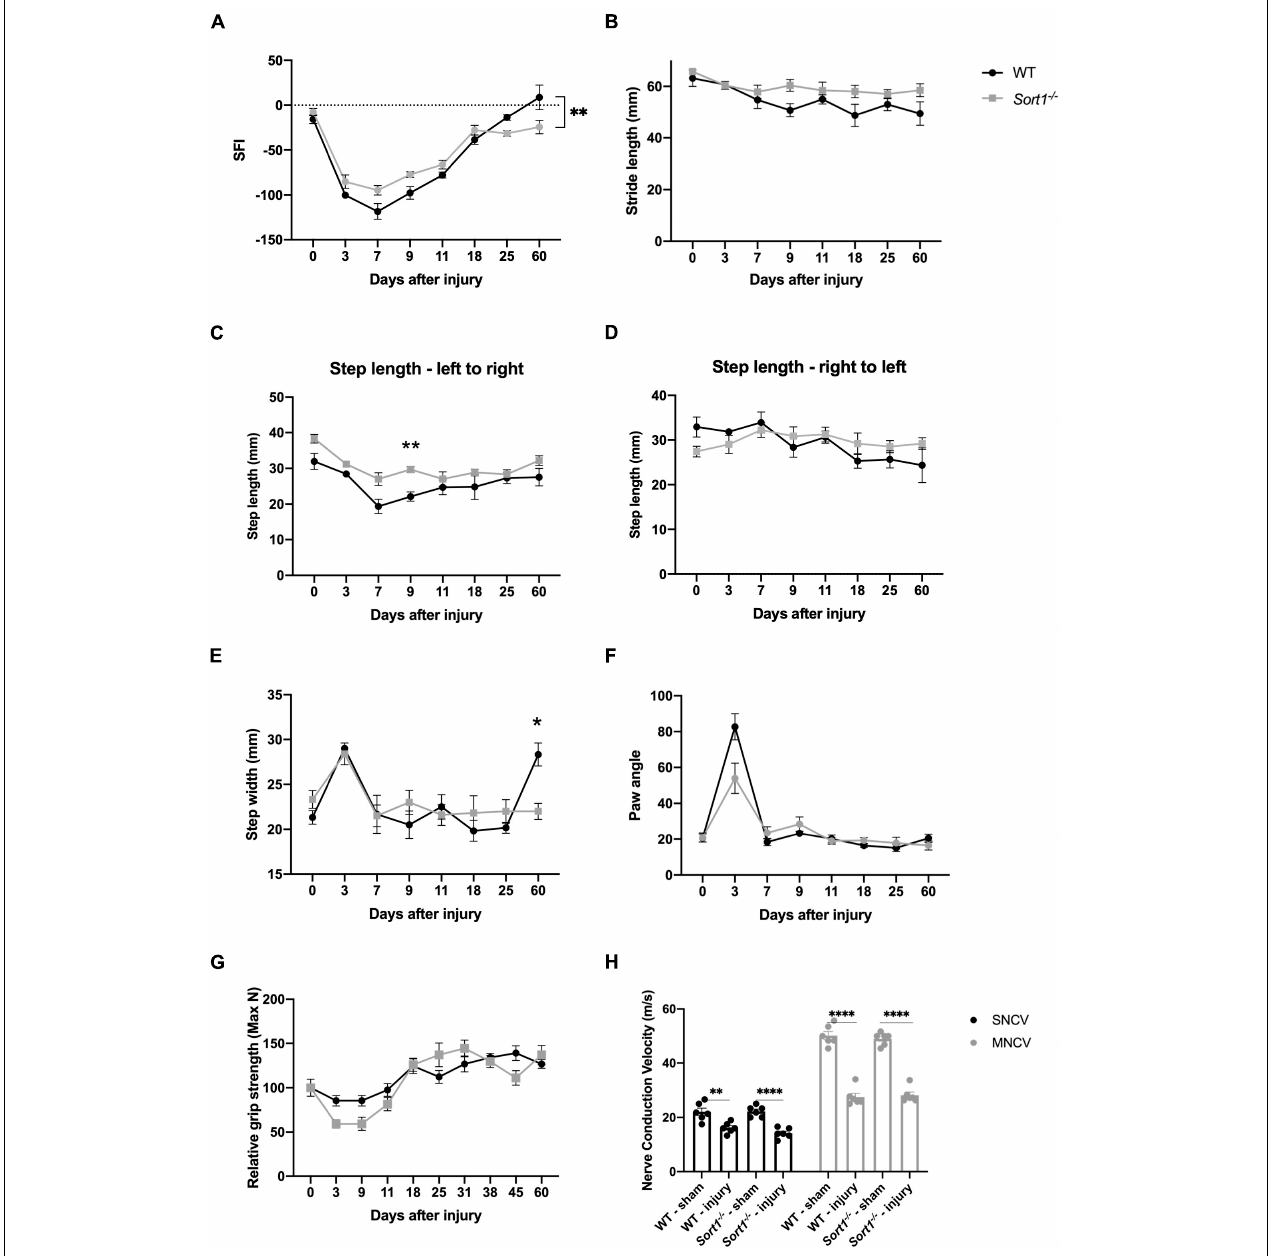
FIGURE 1 | Motor recovery after sciatic nerve crush injury. Motor function recovery of WT and Sort1 − / − mice assessed by walking tract analysis and calculation of (A) SFI, (B) stride length, (C,D) step length, (E) step width, and (F) angle of paw placement to the midline, assessed at pre-treatment (time = 0), 3, 7, 9, 11, 18, 25, and 60 days after nerve crush injury. (G) Grip strength was additionally assessed at pre-treatment (time = 0), 3, 9, 11, 18, 25, 31, 38, 45, and 60 days after nerve crush injury. (H) Nerve conduction velocity analysis of sural (sensory; SNCV) and sciatic (motor; MNCV) nerves 60 days after injury on the ipsilateral and contralateral (sham) side. N = 6 WT mice or 6 Sort1 − / - mice. Statistical significance was established with multiple measures test (A–G) or two-way ANOVA (H) and Bonferroni’s multiple comparisons post hoc test ( ∗ p < 0.05, ∗∗ p < 0.01, ∗∗∗∗ p <